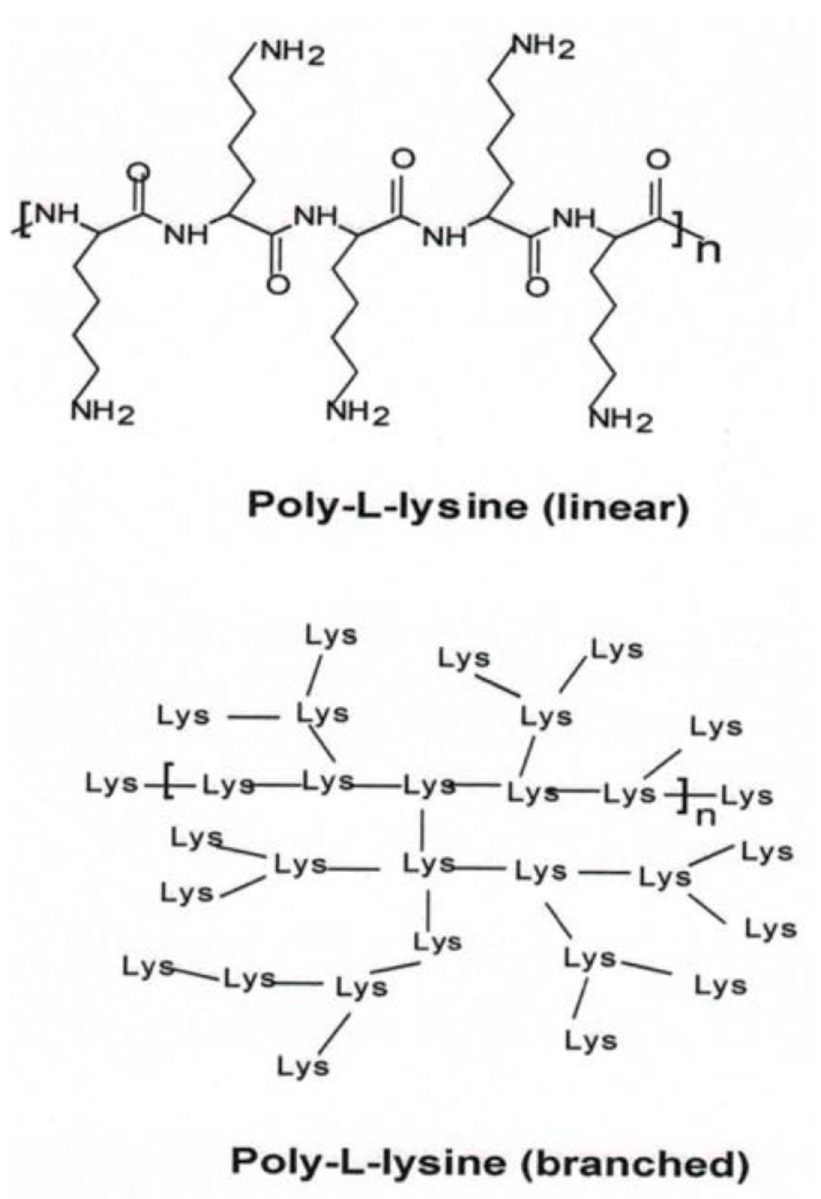
Figure 7. Chemical structures of linear and branched poly-L-lysine.